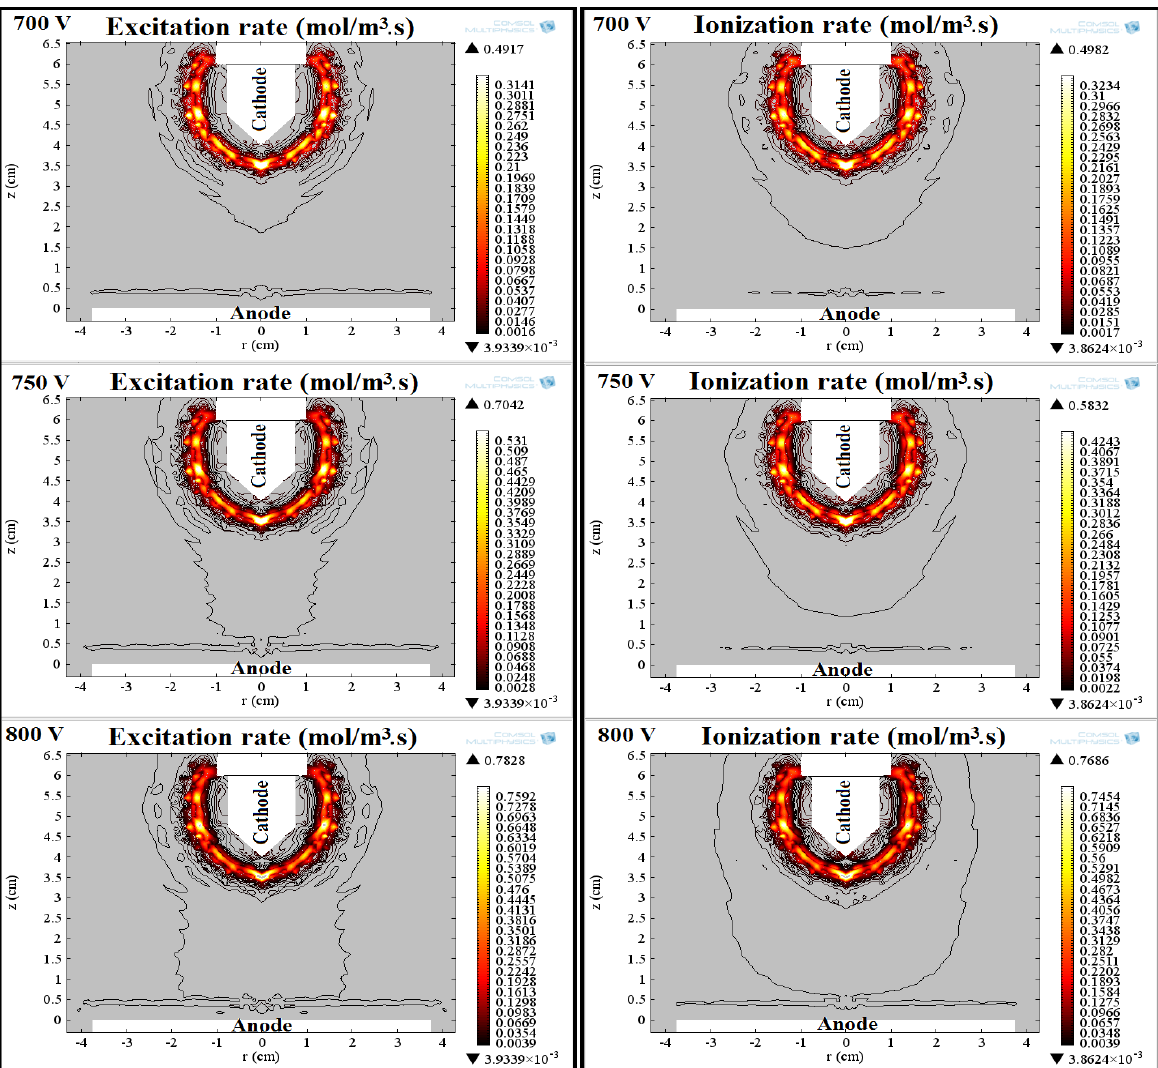
Fig.10: Distributions of excitation rate and ionization rate as a function applied